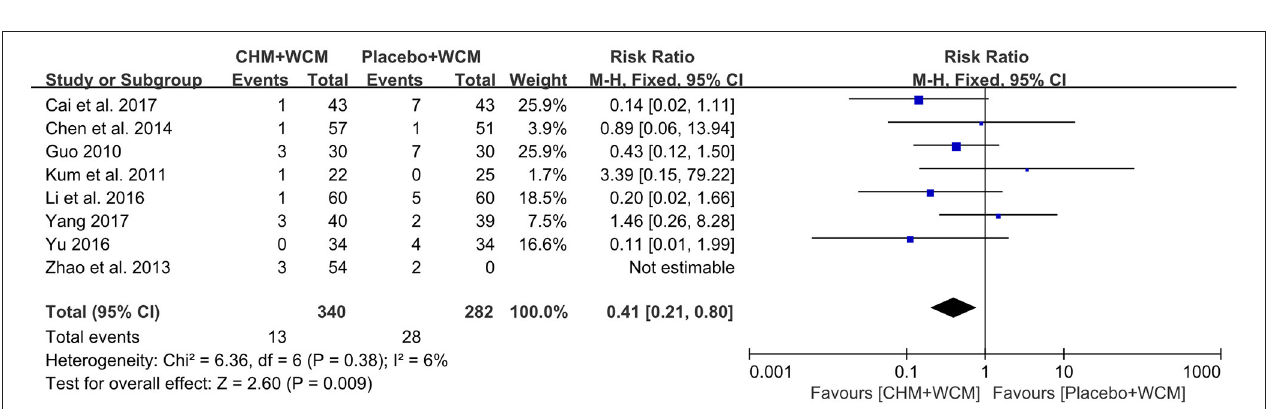
FIGURE 4 | Forest plot of HM plus WCM vs. placebo plus WCM in terms of (A) PDQ-39, (B) NMSS, (C) PDSS, and (D) HAMD. (HM, herbal medicine; WCM, western conventional medicine; PDQ-39, Parkinson’s Disease Questionnaire-39; NMSS, Non-Motor Symptoms Scale; PDSS, Parkinson’s Disease Sleep Scale; HAMD, Hamilton depression rating scale).